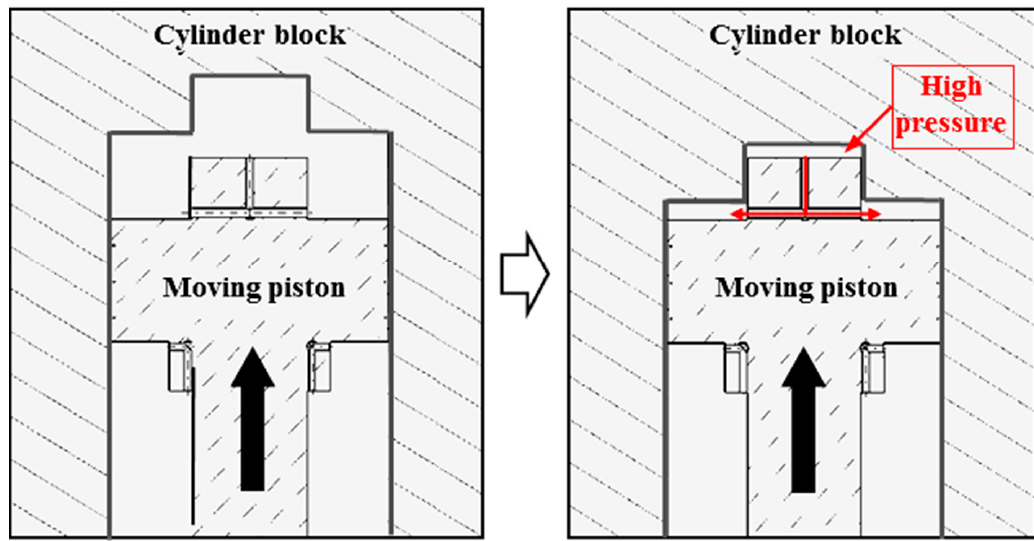
Figure 2. Principle of operation of hydraulic snubber in engine valve closing. Sensors 2017 , 17 , 2940